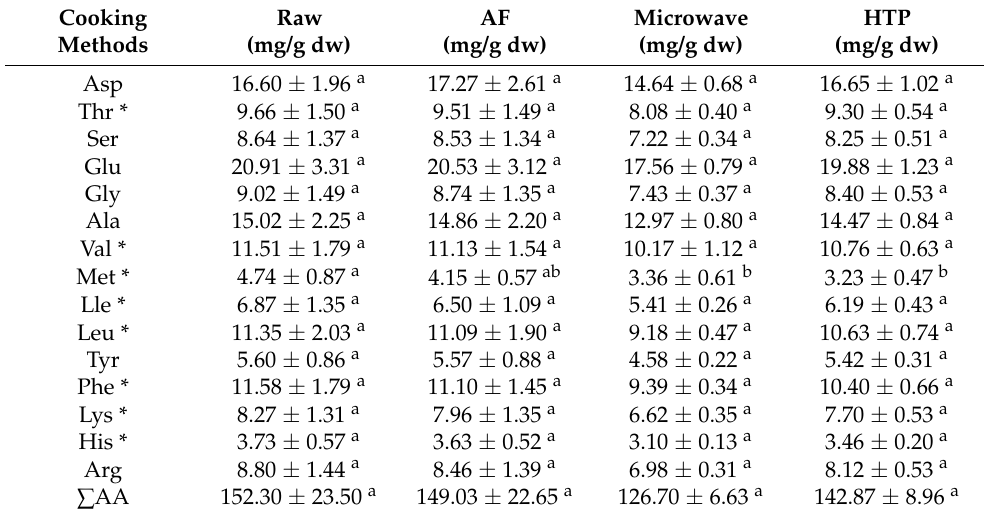
Table 4. Total amino acid content of UP in different cooking